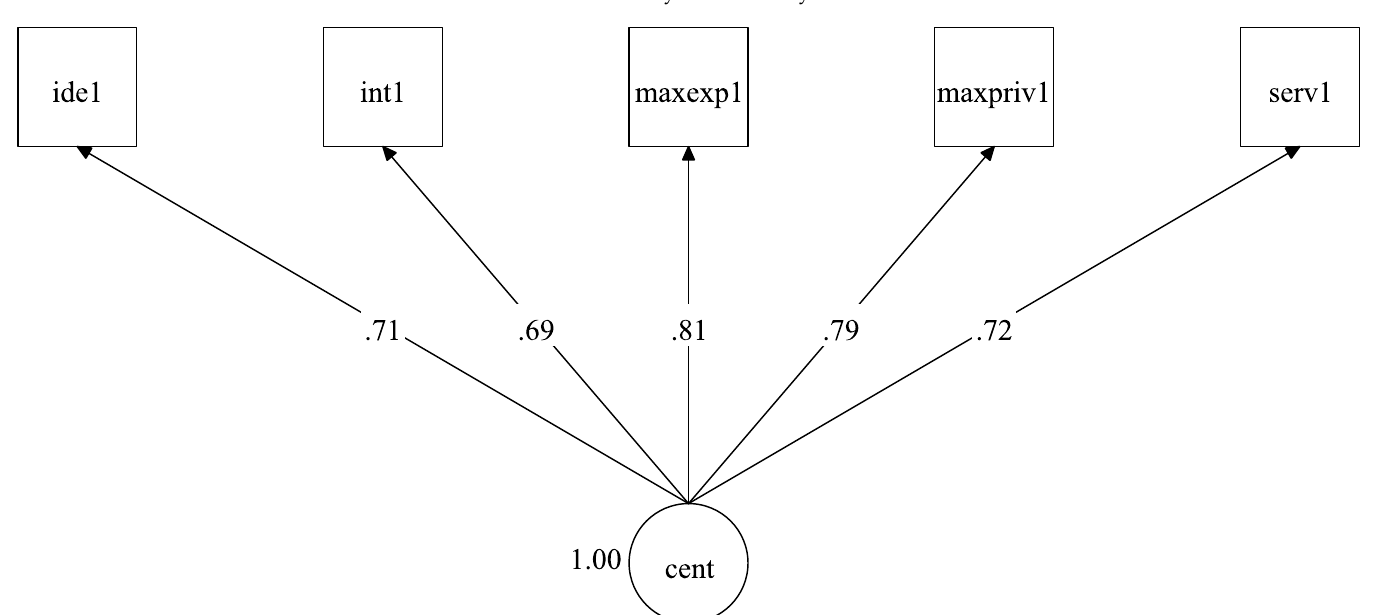
Figure A4. Results of the confirmatory factor analysis of the CRSi-7. Numbers in the plot represent standardized estimates. Cent = centrality of religiosity; int = intellect; ide = ideology; serv = public practice; priv = private practice; exp = experience; max = this prefix means that out of two items, only the one with the higher value for this core dimension is processed in the analysis. The number after the item name indicates the position of the item within the core dimension items. Squares depict manifest and circles latent variables. Residual arrows are not shown for the manifest variables. The numbers on the arrows are factor loadings. The model is identified by setting the variance of the latent variable “cent” to 1.00. All reported estimates are significant with at least α ≤ 0.05 level.